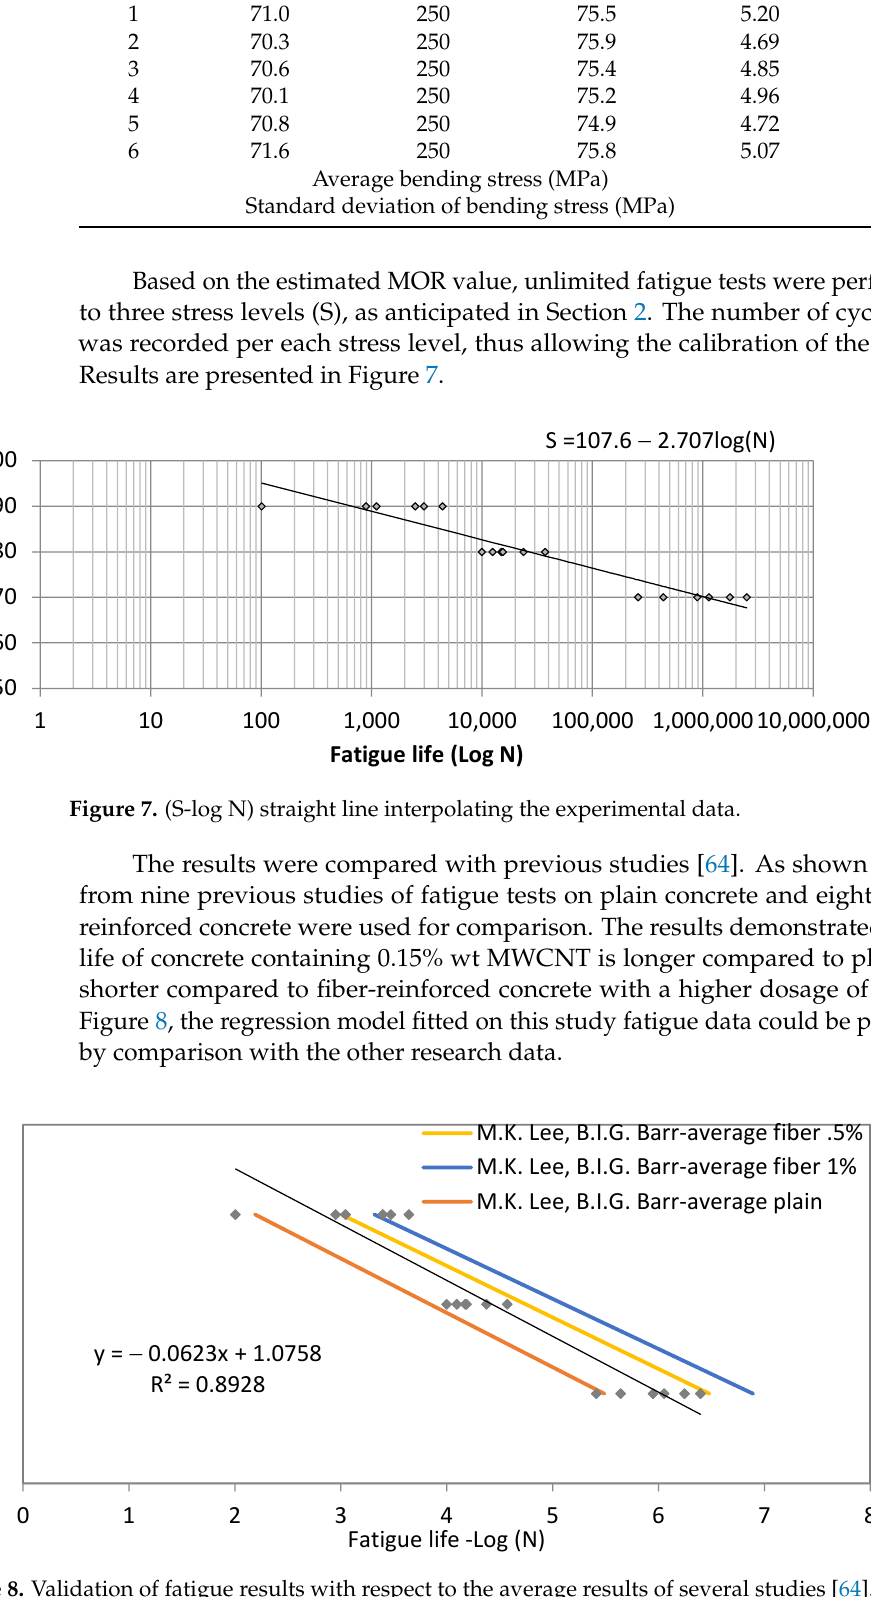
Figure 8. Validation of fatigue results with respect to the average results of several studies [64].